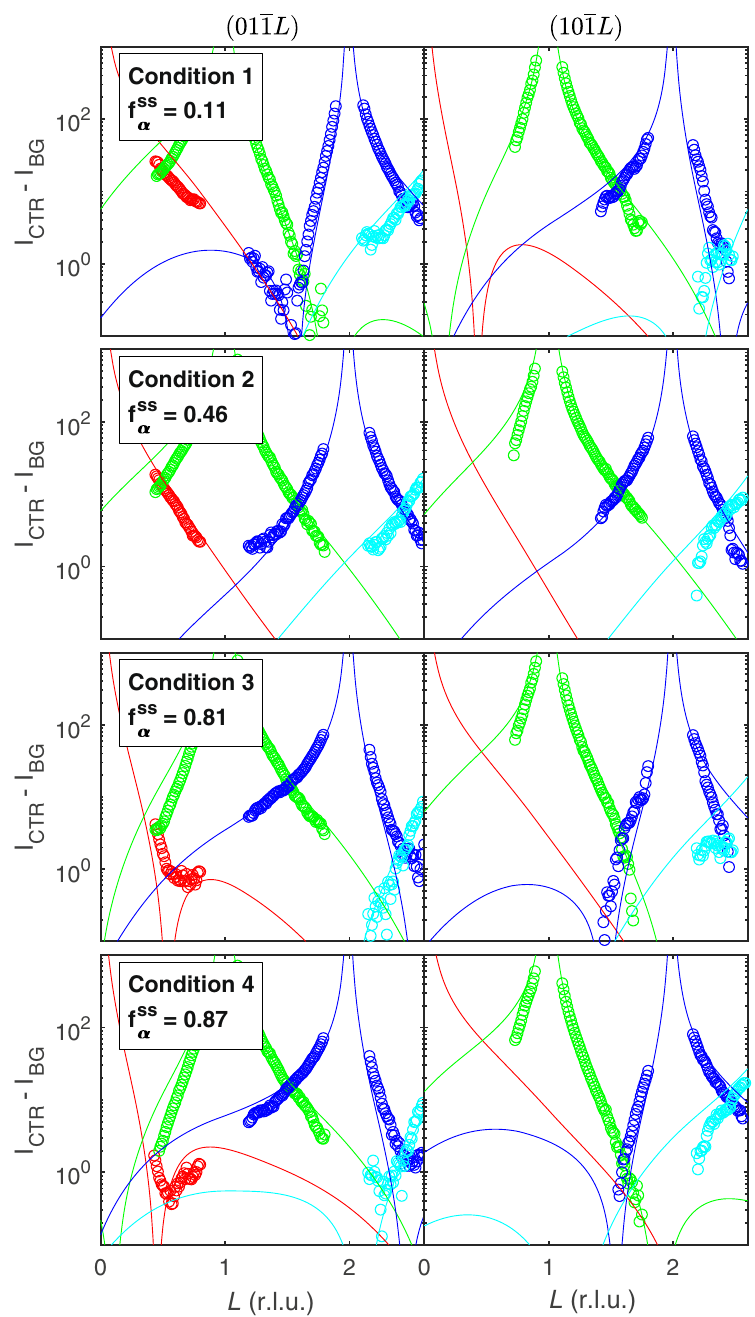
Fig. 5 Measured and calculated crystal truncation rods. Symbols show measured net intensities of the ð 011 L 0 Þ CTRs and the ð 101 L 0 Þ CTRs families (left and right) for CTRs from the L 0 = 0, 1, 2, and 3 Bragg peaks at each of four conditions. Curves show fi ts of all CTRs to obtain steady state α terrace fraction f ss α at each